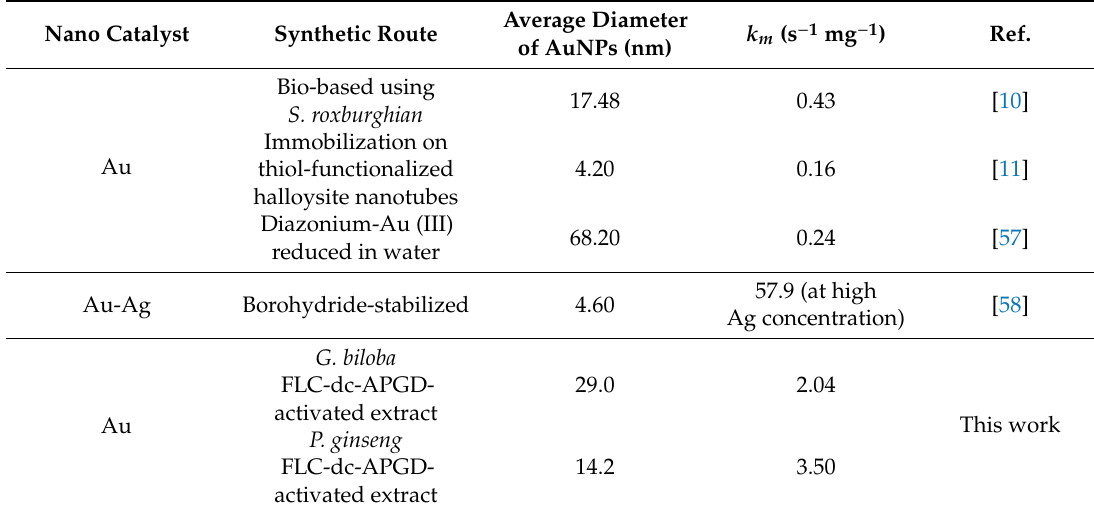
Table 4. Homogenous nanocatalysts for the catalytic decomposition of